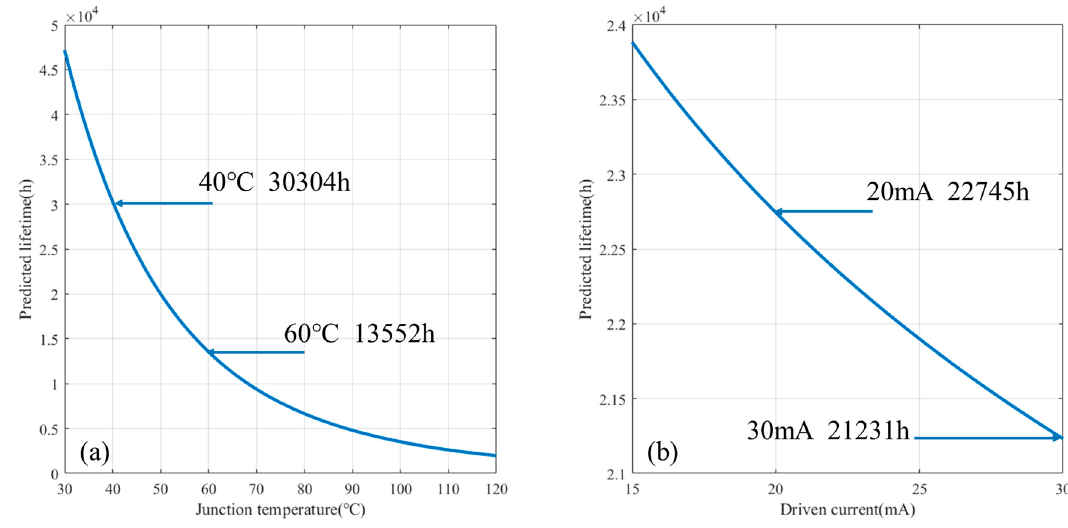
Figure 3. Expected lifetime decays with: junction temperature ( a ); and driving current ( b ).